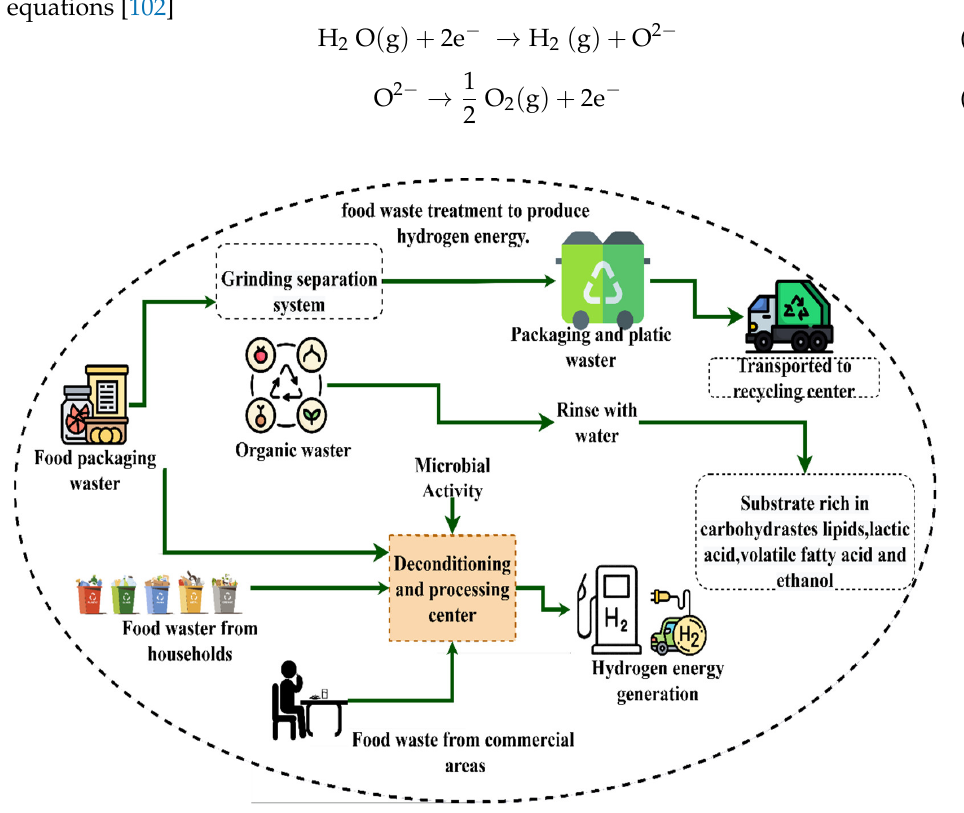
Figure 14. Overview of the most common biohydrogen production technology, main advantages, and problems of the different technologies.